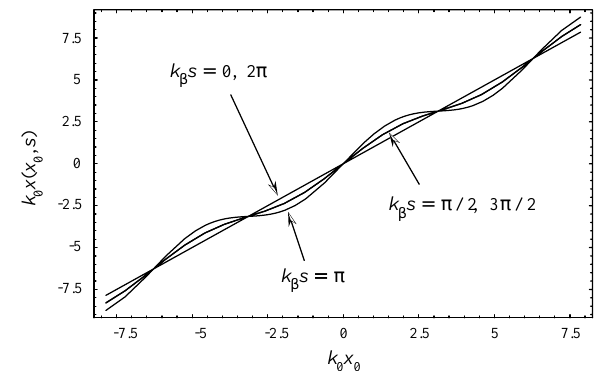
FIG. 10. Plot of k 0 x (cid:1) x 0 , s (cid:2) versus k 0 x 0 obtained from Eq. (100) at k b s (cid:1) 0, p (cid:3) 2, p , 3 p (cid:3) 2, 2 p for the choice of system param- eters s b (cid:1) 1 , D (cid:1) 0.45 , and k 0 x b 0 (cid:1) 5 p (cid:3) 2 .